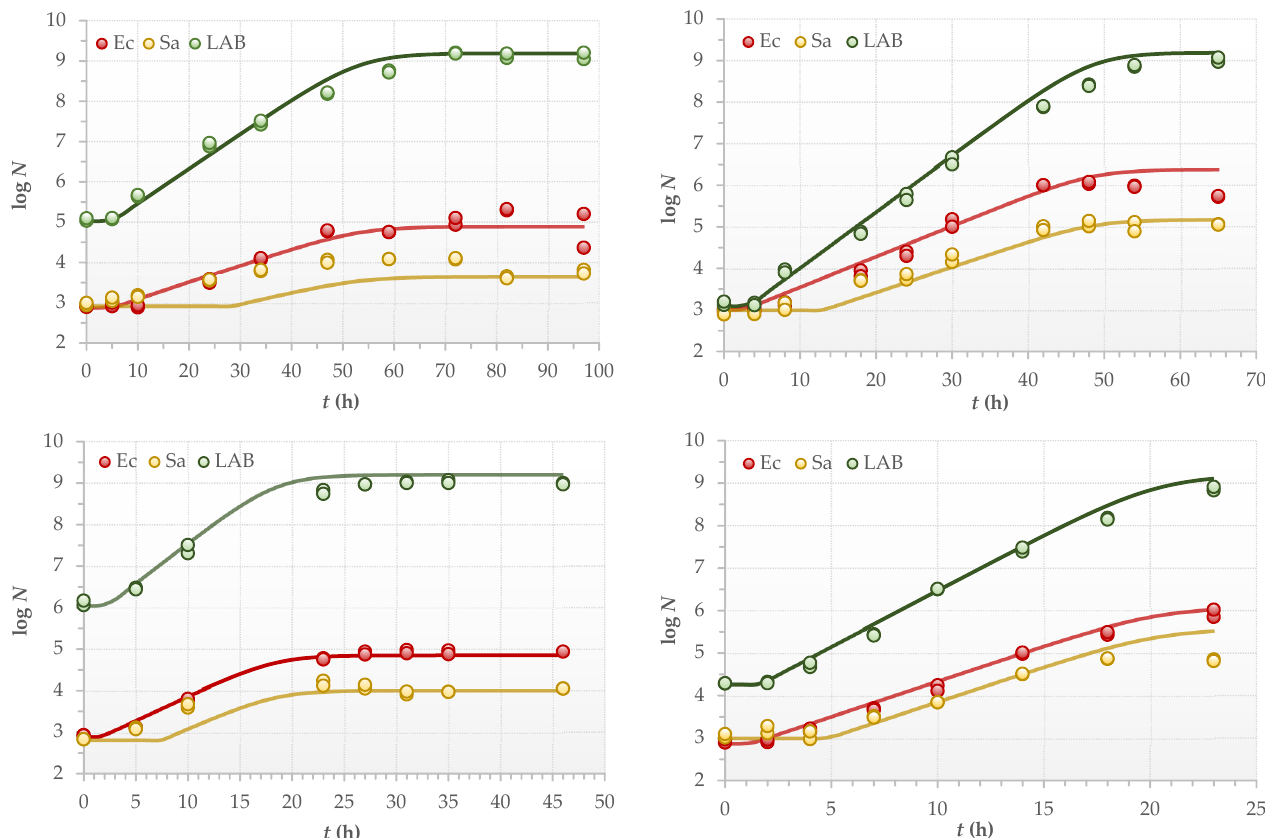
Figure 1. Co-culture growth of E. coli , S. aureus, and four different inocula of LAB Fresco in milk at 12 ◦ C ( upper left , N 0, LAB ~ 5 log CFU mL − 1 ), 15 ◦ C ( upper right , N 0, LAB ~ 3 log CFU mL − 1 ), 18 ◦ C ( lower left , N 0, LAB ~ 6 log CFU mL − 1 ), and 21 ◦ C ( lower right , N 0, LAB ~ 4 log CFU mL − 1 ). The continuous lines represent the growth predicted by the H-GD1-model and dots represent the actual logarithmic counts (log N ) in selected time